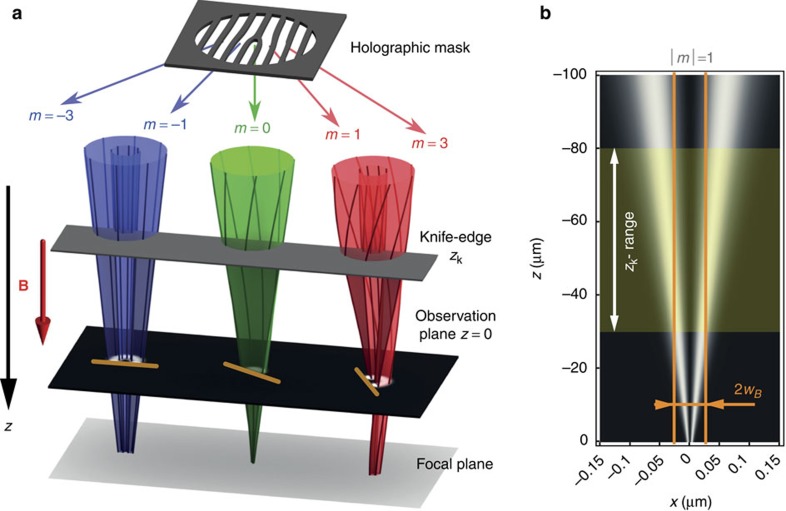
Schematics of the experiment and the beam parameters.(a) A holographic fork mask generates a row of vortex beams with different azimuthal indices m=..., −5, −3, −1, 0, 1, 3, 5, ... (refs 19, 20). These beams are focused by a magnetic lens and are studied in the region of maximal quasi-uniform magnetic field. The focal plane is shifted few Rayleigh ranges below the observation plane z=0 to reduce the Gouy-phase rotation4647. A knife-edge stop is placed at zk<0, where it blocks half of each of the beams. Varying the position zk of the knife edge, we observe spatial rotational dynamics of the cut beams propagating to the observation plane (see Fig. 1). (b) Intensity distribution in the |m|=1 beams. The radius w of the focused beams varies slowly with z. In the highlighted range zε(−80, −30) μm, the beam radius approaches the magnetic radius, w(z)≃wB, and the beams acquire the Landau-state properties (see Figs 3 and 4).